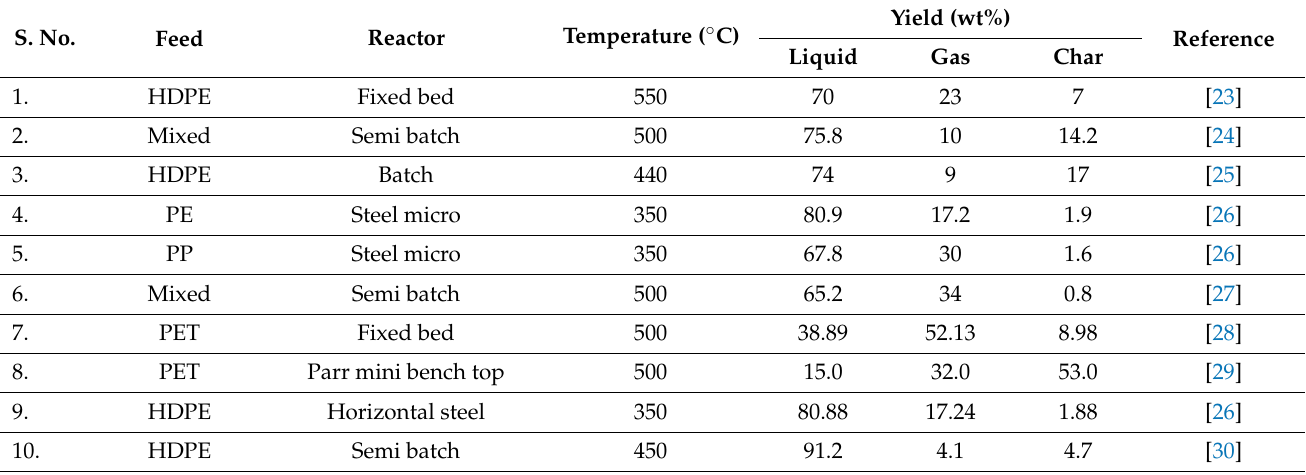
Table 1. Summary of research studies carried out by various research groups on thermal pyrolysis of plastic